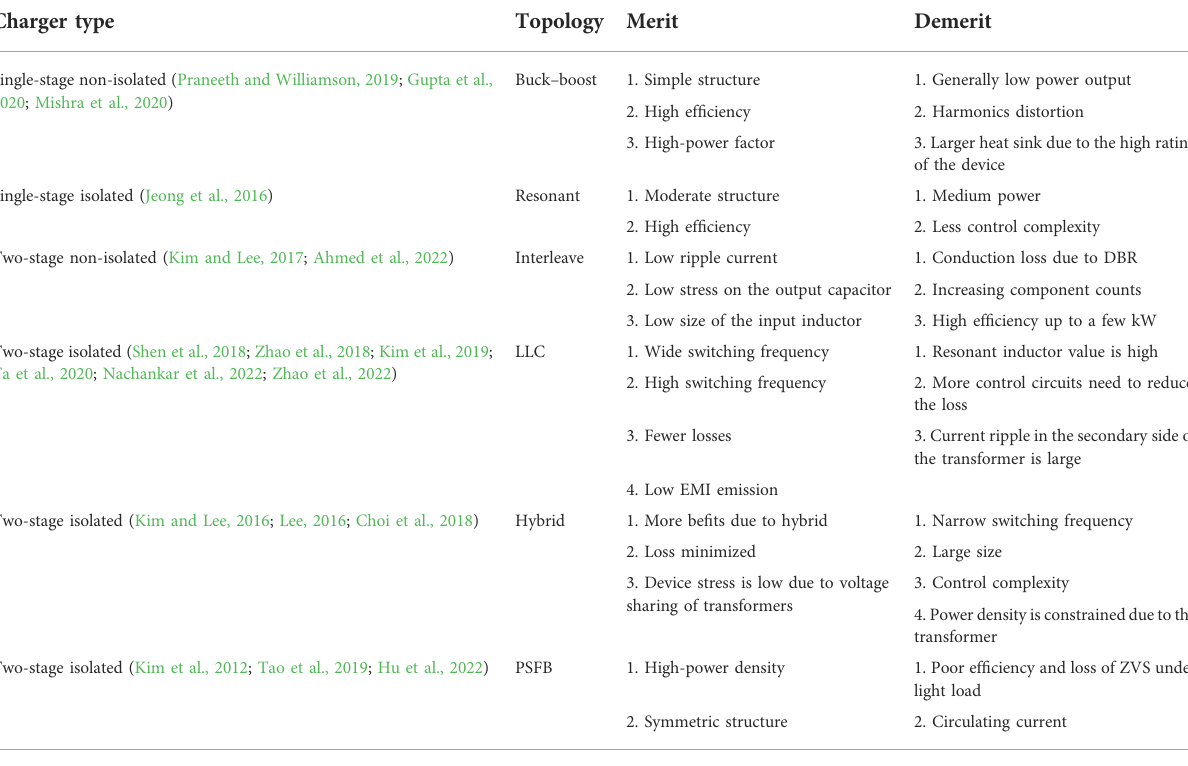
TABLE 9 Unidirectional charger